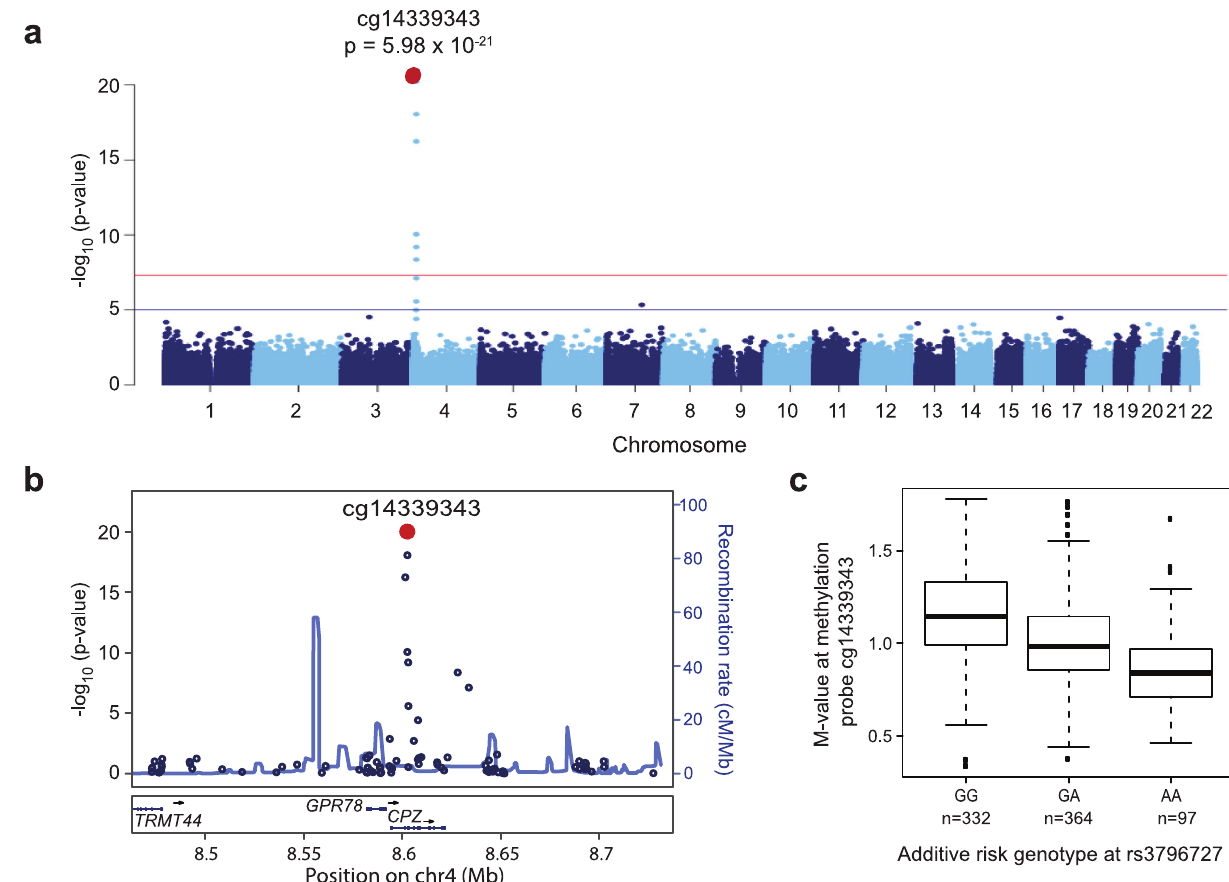
Fig 4. Methylation genome-wide association study (meGWAS) identifies rs3796727 as a methylation quantitative trait loci (meQTL) for sites in CPZ . (a) Manhattanplot of meGWAS results in 793 individualsbased on additivers3796727genotype. A single genome-wide significantassociationis identified and the most statistically significantmethylationprobe is labeled(cg14339343). (b) LocusZoom plot at 4p16 locus reveals cg14339343 maps to the CPZ gene. Y-axes represent the significance of association(-log10transformed P values) and the recombination rate. (c) Box plot of M-values based on rs3796727 genotypein 793 individuals. The rs3796727risk allele“A” is associated with decreased methylation.